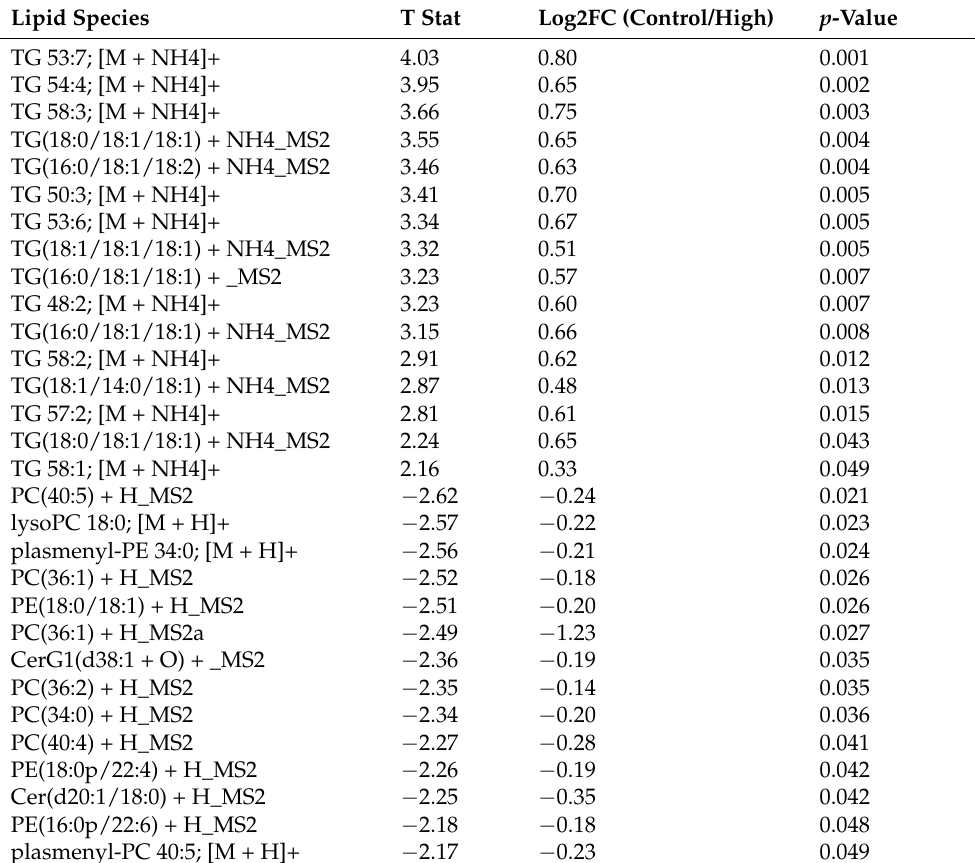
Table 1. Lipid species in the hippocampus detected using positive ionization mode in piglets fed the higher dose of MFGM infant formula compared to piglets fed the control infant formula. Note, annotations highlight the ionization adduct detected, and annotations ending with _MS 2 are based on MS 2 spectral matches to the LipidSearch library. A p -value < 0.05 indicates a significant effect. Abbreviations: T-statistic (T-stat) and log2 fold change (Log2FC). TG = triacyglyceride, PC = phosphatidylcholine, lysoPC = lysophosphatidylcholine, PE = phosphatidylethanolamine, CerG1 = monoglycosylceramide, Cer = ceramide. A positive Log2FC indicates a lower abundance in the MFGM-fed piglets and vice